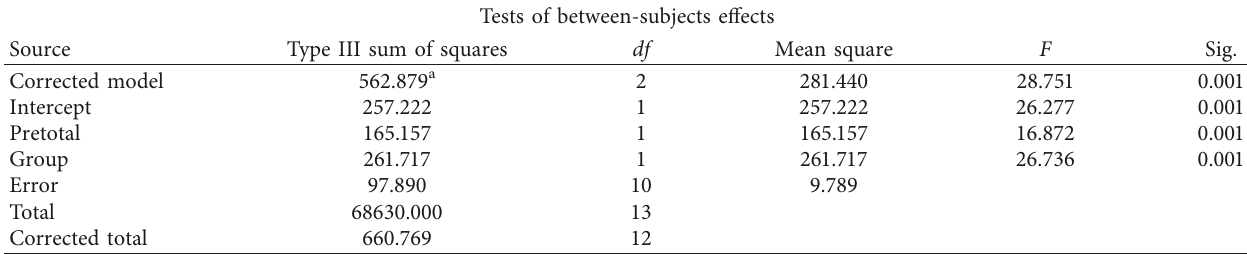
Table 9: ANCOVA of high-achiever students.